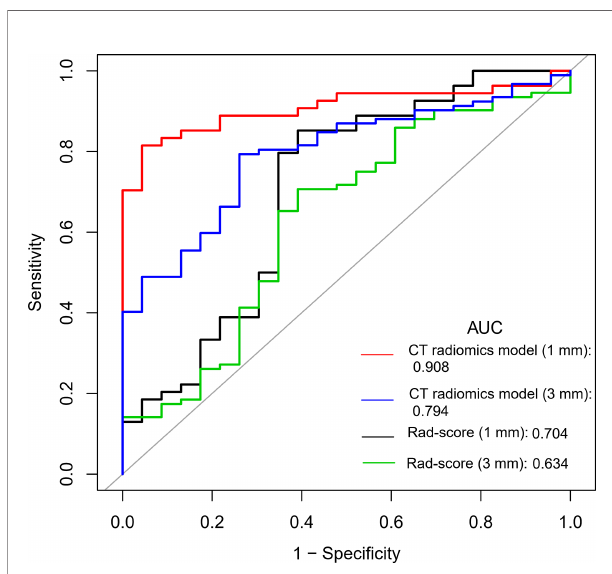
FIGURE 2 | Comparison of ROC curves between Rad-score and radiomics models with different CT reconstruction slice